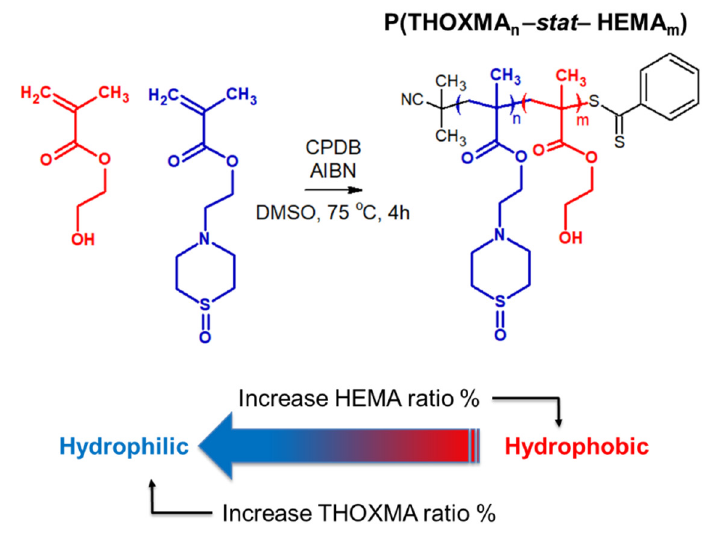
Figure 3. Structure of statistical copolymers of HEMA and THOXMA.